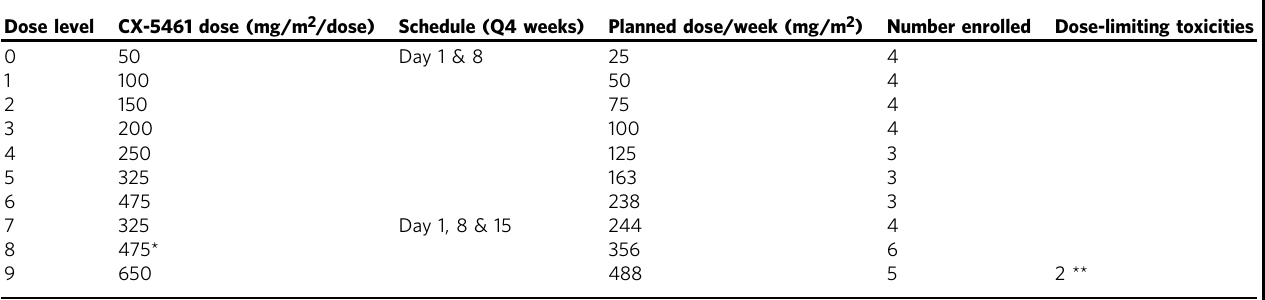
Table 2 Dose levels, schedule, and dose-limiting toxicity.